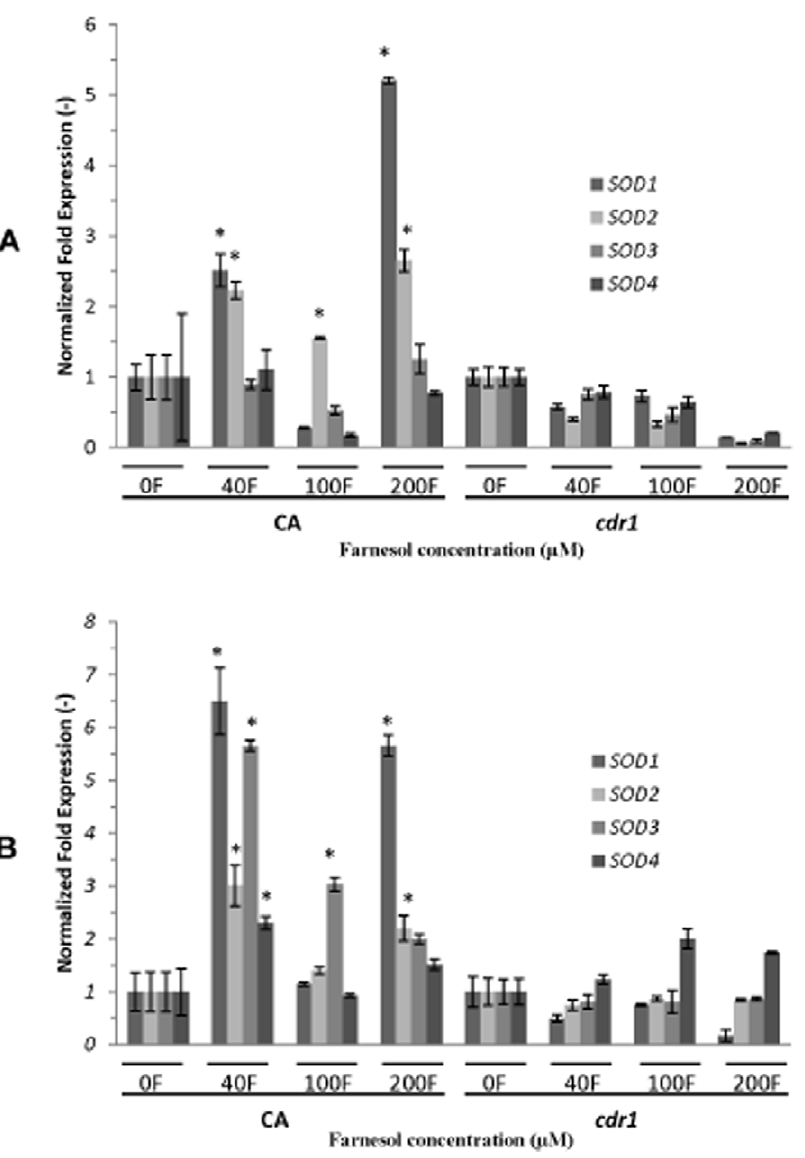
Figure 8. Effect of farnesol on the expression of the SOD1-4 genes in CA and cdr1 cells following 3 h and 18 h exposure to increasing concentrations of farnesol as determined by qRT-PCR analysis. ( A ) Significant differential expression in SOD genes in CA at 3 h with no significant variation in cdr1 . ( B ) Similar but more pronounced expression profiles were seen at 18 h in both strains. Expression is normalized against ACT1 as reference gene. Data represent the average of 3 independent experiments performed in triplicate. Error bars indicate the standard errors of the means. p , 0.05.